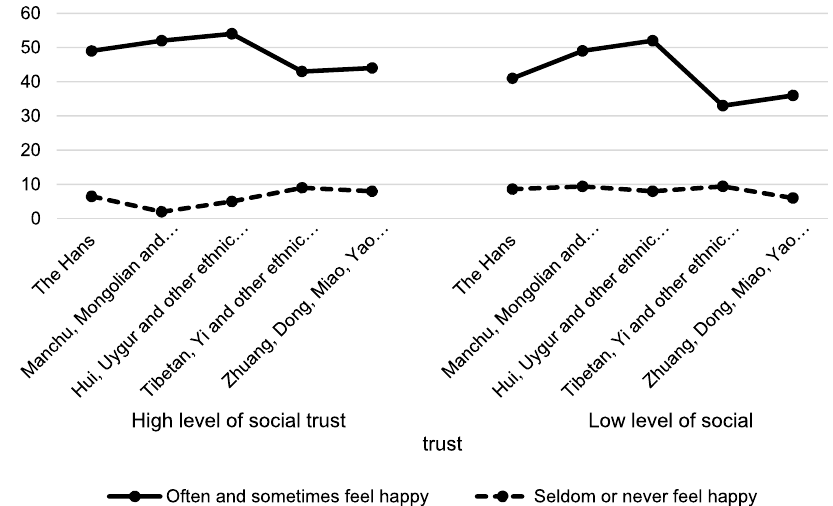
Fig. 6 Emotional integration and subjective well-being of ethnic groups (percentages)